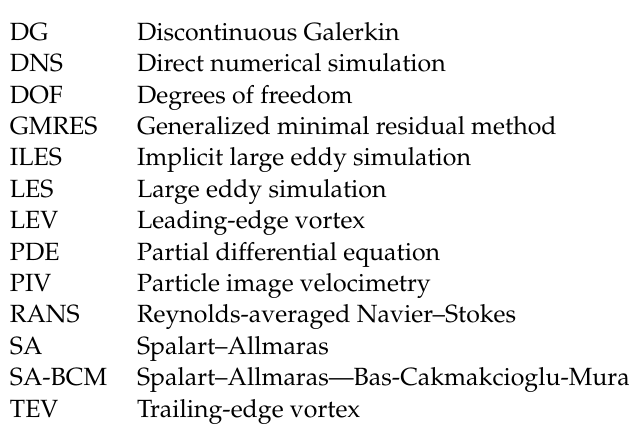
in Figure 5a. Video S2: Time evolution of the vorticity field in Figure 5b. Video S3: Time evolution of the vorticity field in Figure 5c. Video S4: Time evolution of the vorticity field in Figure 5d. Video S5: Time evolution of the vorticity field in Figure 5e. Video S6: Time evolution of the vorticity field in Figure 5f. Video S7: Time evolution of the vorticity field in Figure 5g. Video S8: Time evolution of the vorticity field in Figure 5h. Video S9: Time evolution of the vorticity field for Case 1, SA-BCM model (Figure 9). Video S10: Time evolution of the vorticity field for Case 1, SA model (Figure 10). Video S11: Time evolution of the intermittency function field for Case 1 (Figure